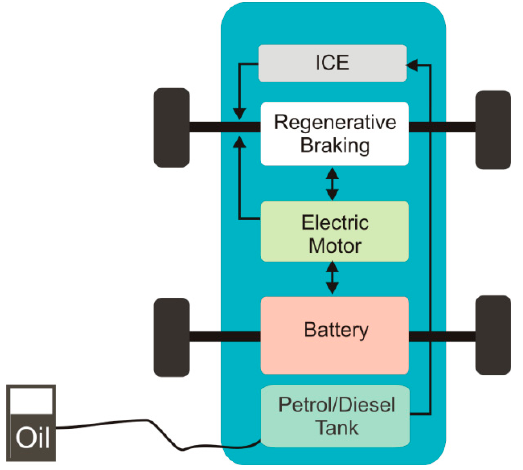
Figure 5. Architectural diagram of hybrid electric vehicles (HEVs).